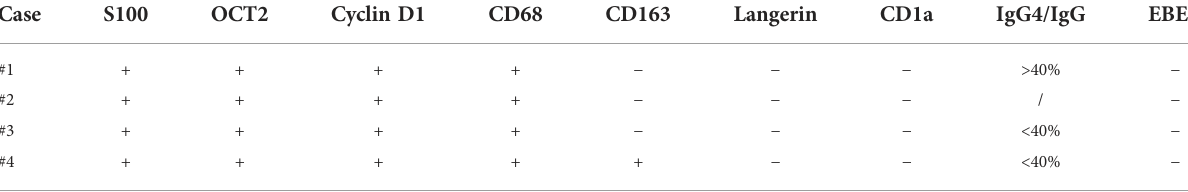
TABLE 3 Immunophenotype and EBV infection status of four primary intraosseous RDD.